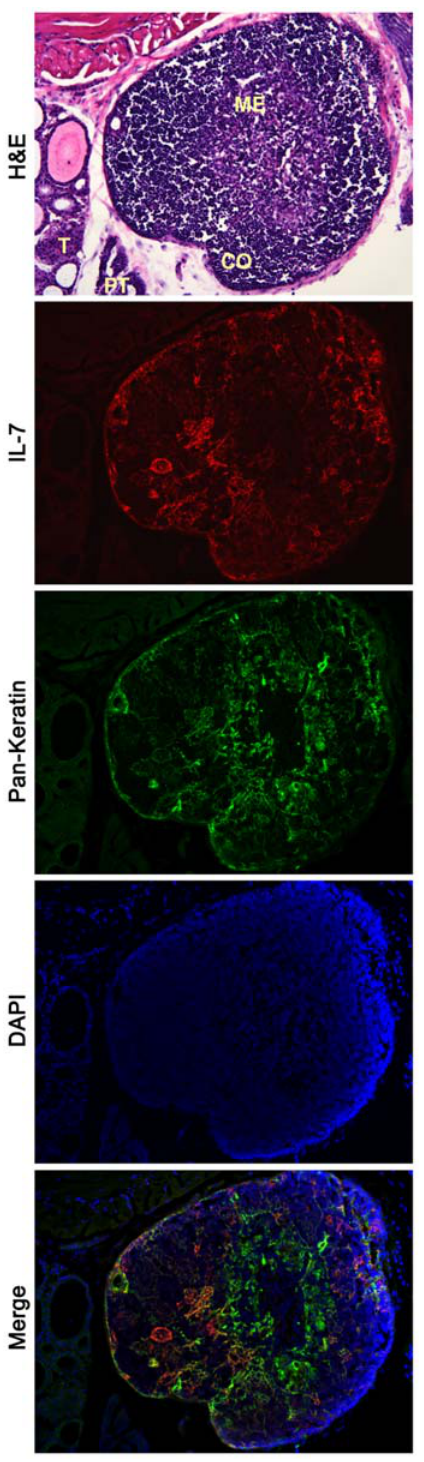
Figure 6. Cervical thymus contains IL-7-producing cells. H&E staining shows the cortical (CO) and medullary (ME) organization of the cervical thymus. ECFP (counterstained red) is mainly expressed in cortex by stromal cells (anti-pan keratin Ab, green staining). The wide spectrum anti-keratin antibody stains keratin-8 and keratin-5 among others, showing stromal cells present both in cortex and medulla. Magnification 200 6 . T, thyroid; PT, parathyroid.